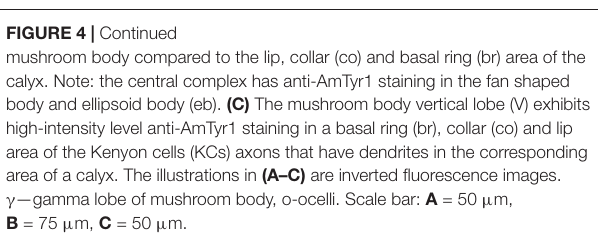
Frontiers in Systems Neuroscience |